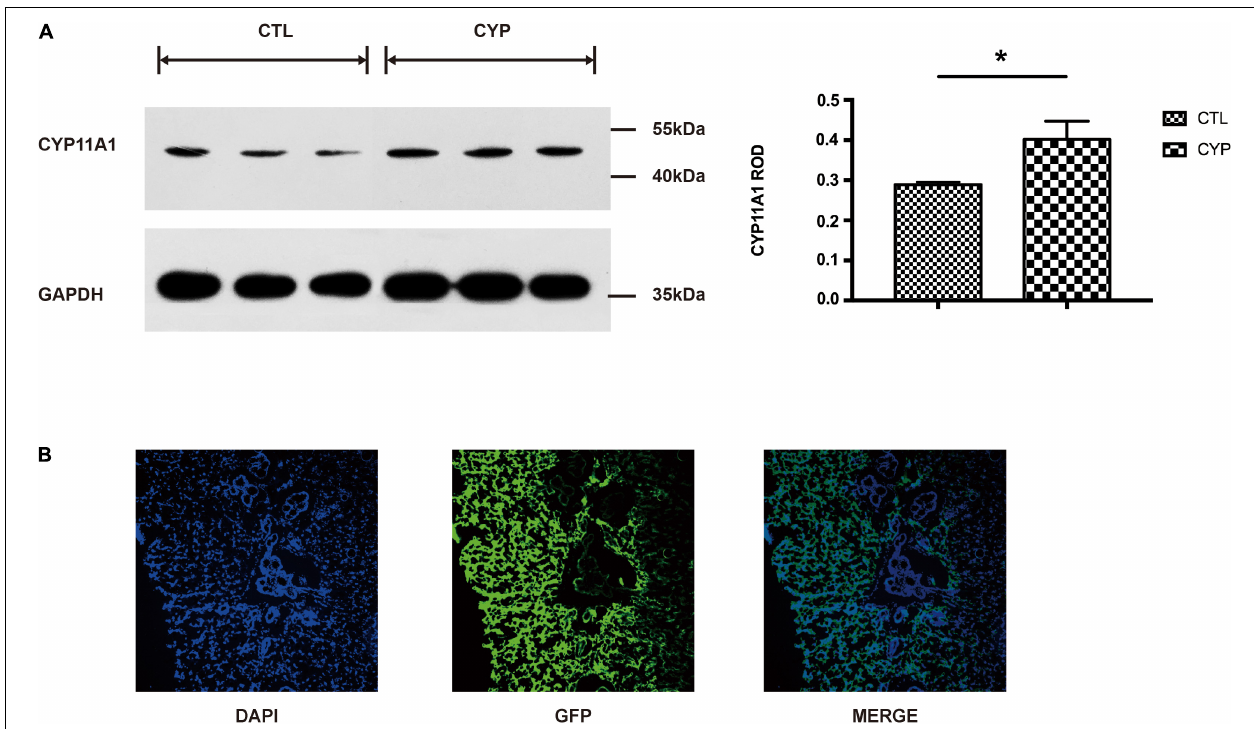
FIGURE 1 | A rat model of CYP11A1 -overexpressing dams was successfully established. (A) Western blot result shows that CYP11A1 adenovirus injection lead to overexpression of CYP11A1 in placenta. The right panel is the statistic result. (B) Immunostaining analysis revealed green fluorescent protein (GFP) signaling in the placentas of CYP11A1 -overexpressing dams. N = 3 for each group (* P <